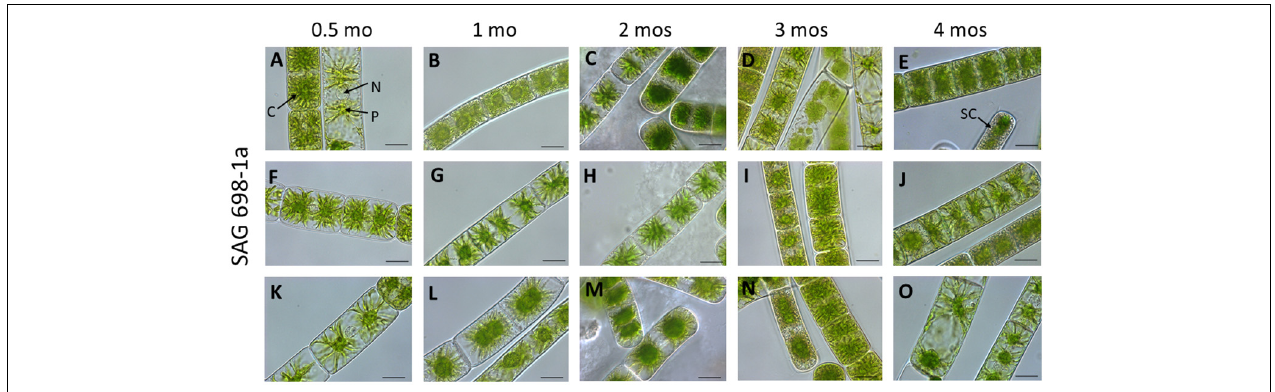
FIGURE 2 | Vegetative cells of SAG 698-1a at different culture ages (time after transfer to fresh medium). (A,F,K) 0.5 mo; (B,G,I) 1 mo; (C,H,M) 2 mos; (D,L,N) 3 mos; (E,J,O) 4 mos; Arrow pointing labels: C chloroplast; N nucleus; P pyrenoid; and SC storage compounds. Images were taken with a Zeiss Axiovert 200 M (Carl Zeiss, Jena, Germany); scale bars: 20 µ